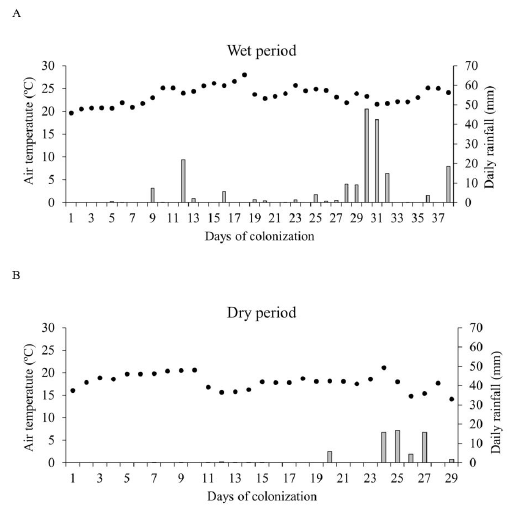
Figure 2. Air temperature (ºC) and daily rainfall (mm) during the (A) wet and (B) dry